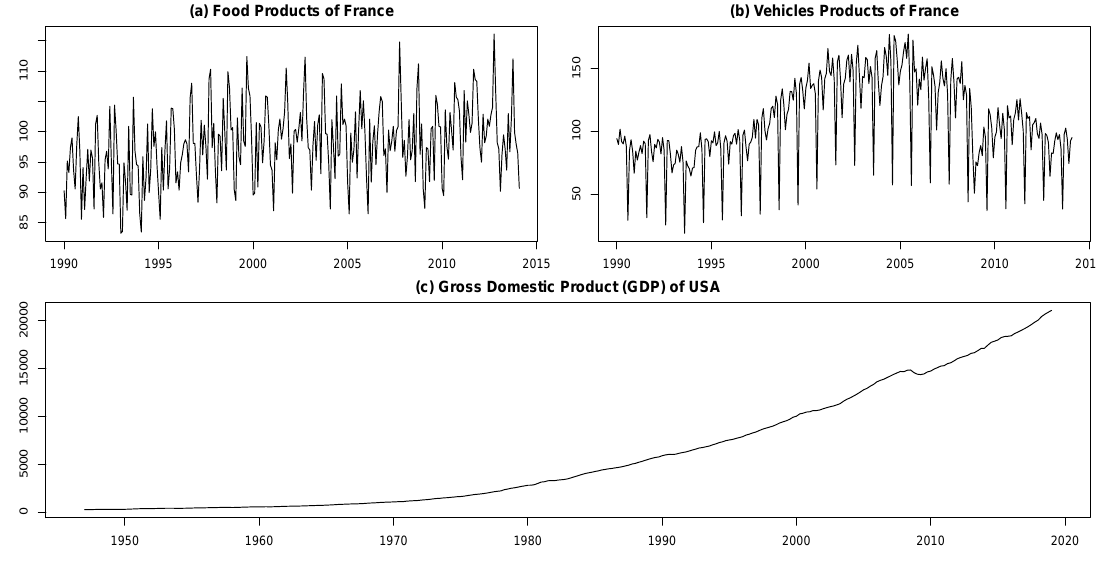
Figure 8. Time series plot of real-world